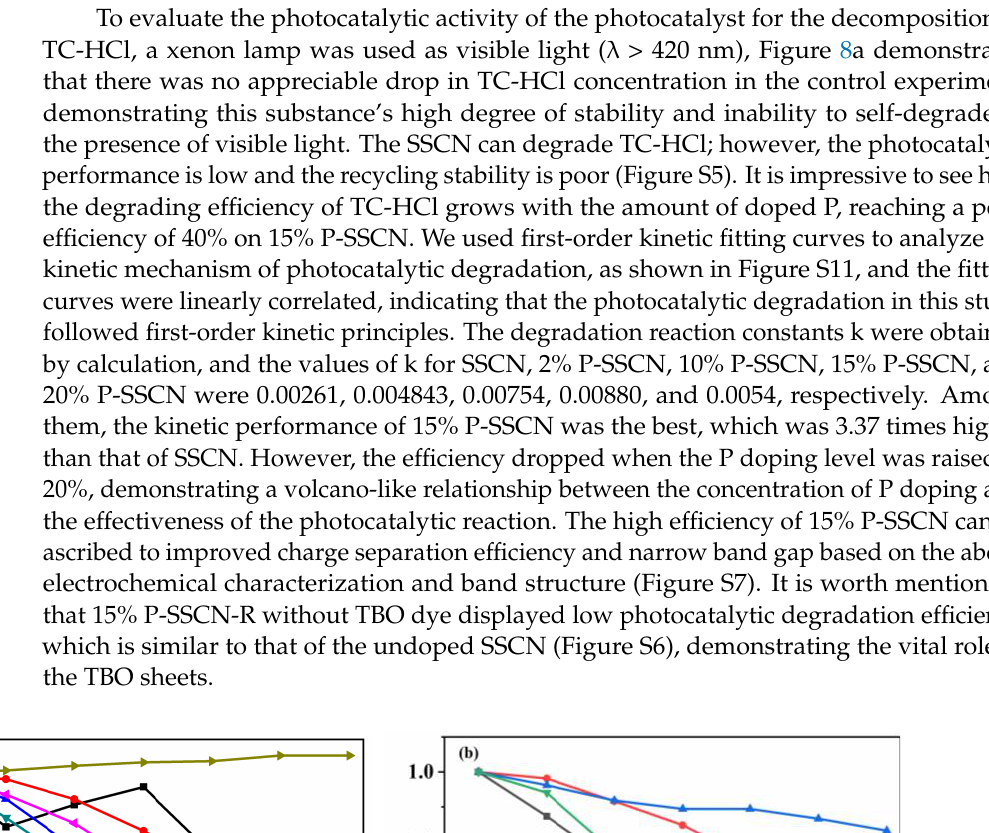
Figure 7. ( a ) Photocurrent response curves and ( b ) electrochemical impedance spectroscopy of SSCN, 10% P-SSCN, 15% P-SSCN, and 20% P-SSCN under visible light irradiation.